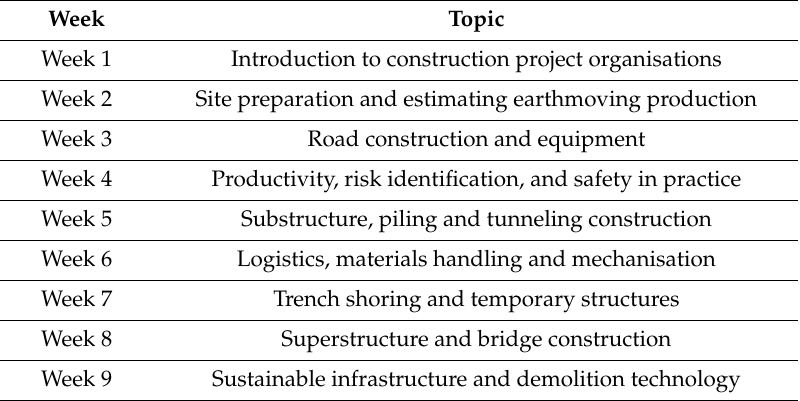
Table 4. Selected topics covered in the case chosen